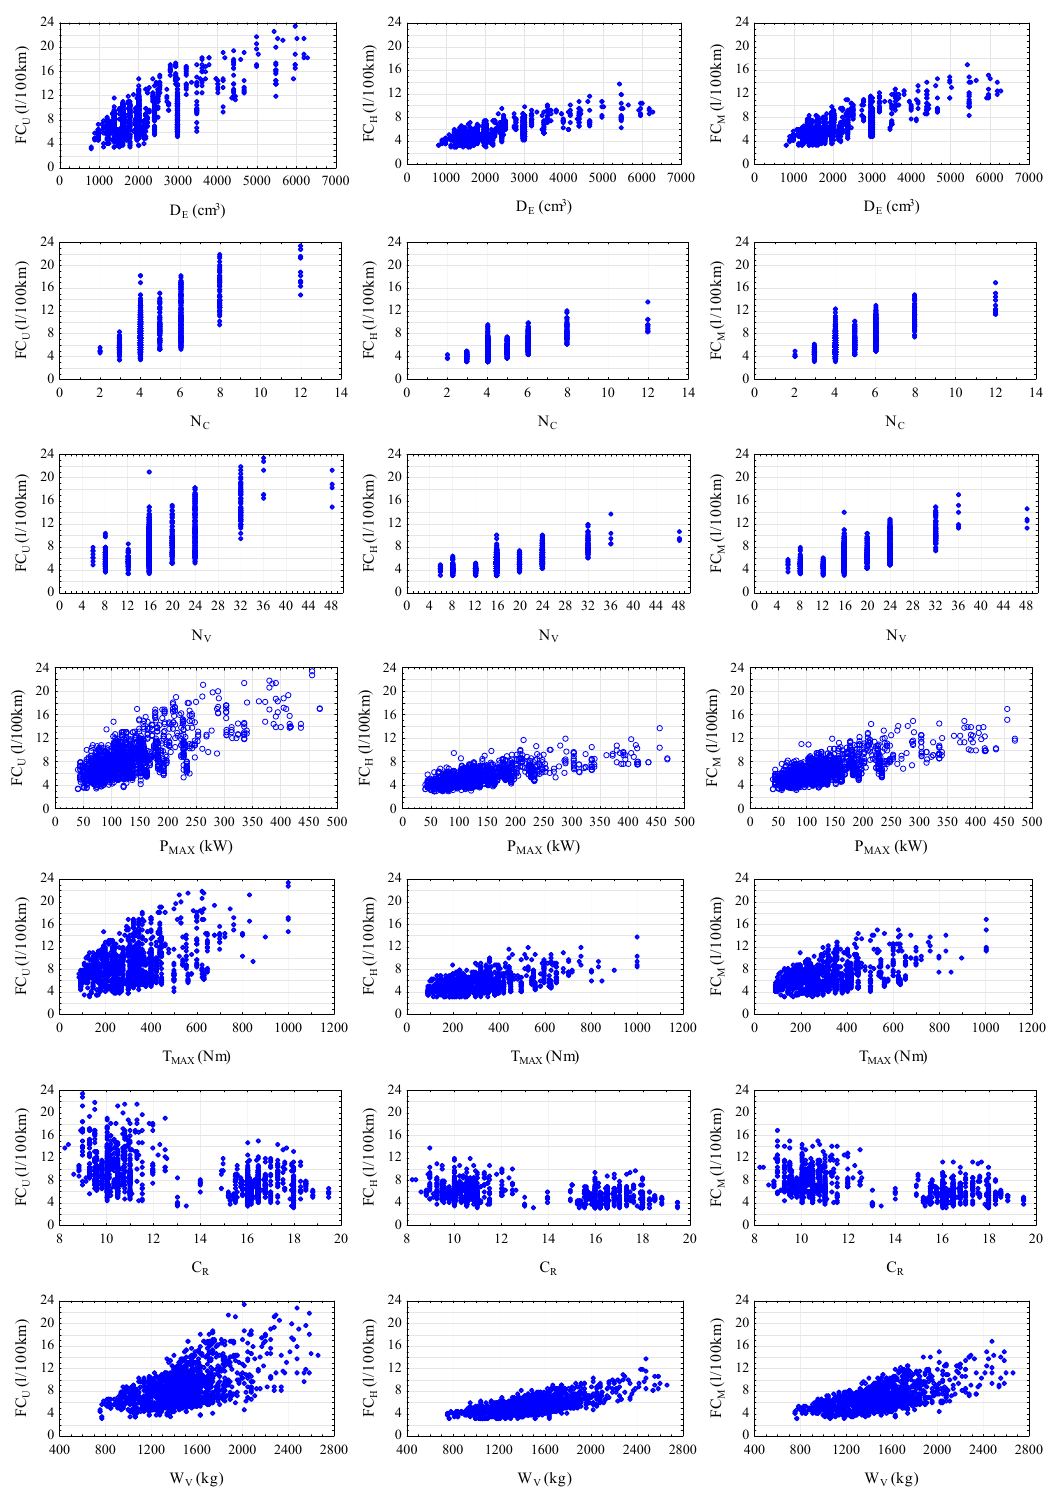
Figure 2. Fuel consumption depending on the quantitative input variables.